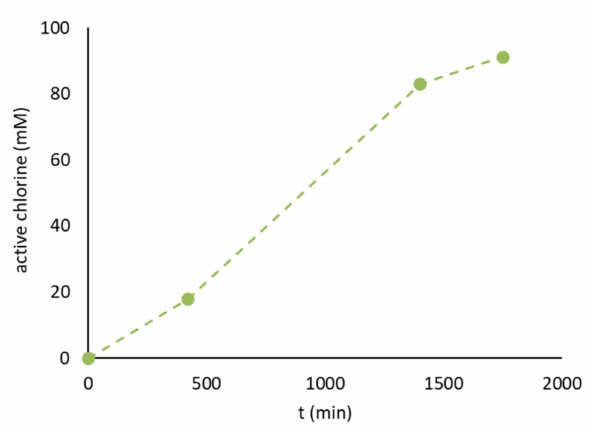
Figure 8. Trends with time of the concentration of active chlorine produced during a degradation run at 1.8 V with solution containing 40 mg dm − 3 of DEP, 0.1 M NaClO 4 , and 100 mM of Cl −